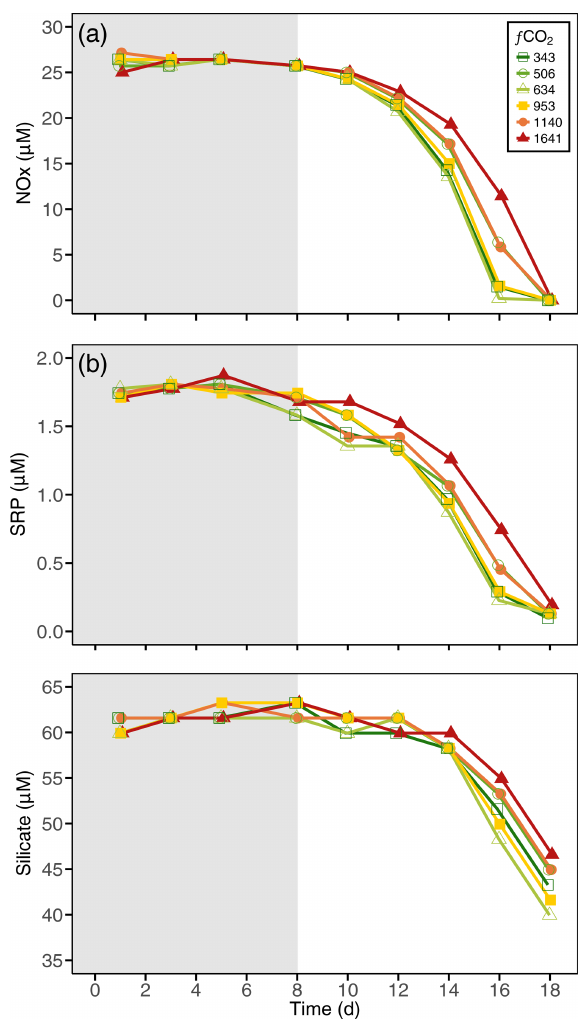
Figure 5. Nutrient concentration in each of the minicosm treatments over time. (a) Nitrate + nitrite (NO x ), (b) soluble reactive phospho- rus (SRP), and (c) molybdate reactive silica (silicate). Grey shading indicates CO 2 and light acclimation period.